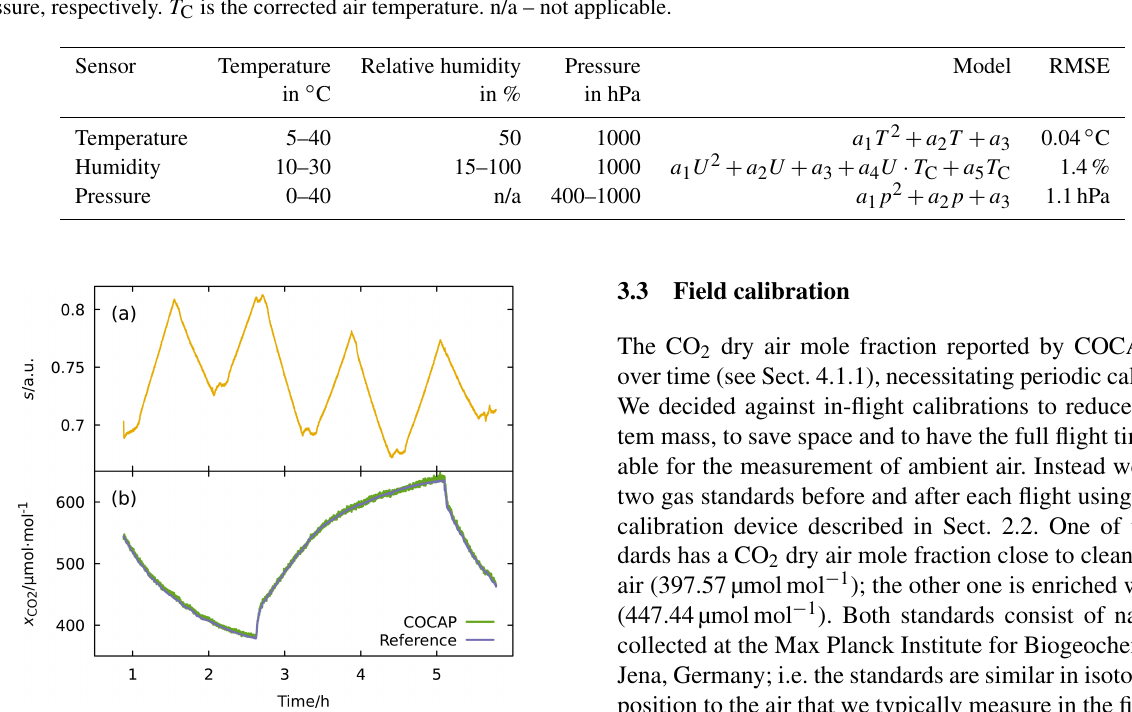
Table 1. Summary of the calibration of COCAP’s ambient sensors: conditions during calibration, correction model and root mean square error (RMSE) of the corrected indications with respect to the reference. T , U and p are uncorrected temperature, relative humidity and pressure, respectively. T C is the corrected air temperature. n/a – not applicable.